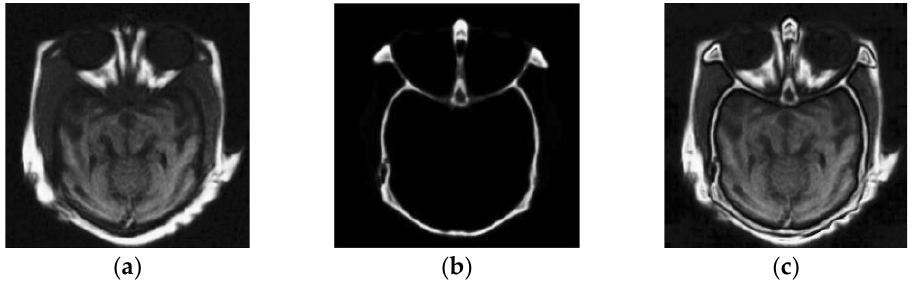
Figure 7. Image fusion in the field of clinical imaging: ( a ) MRI; ( b ) CT; ( c ) fusion image.